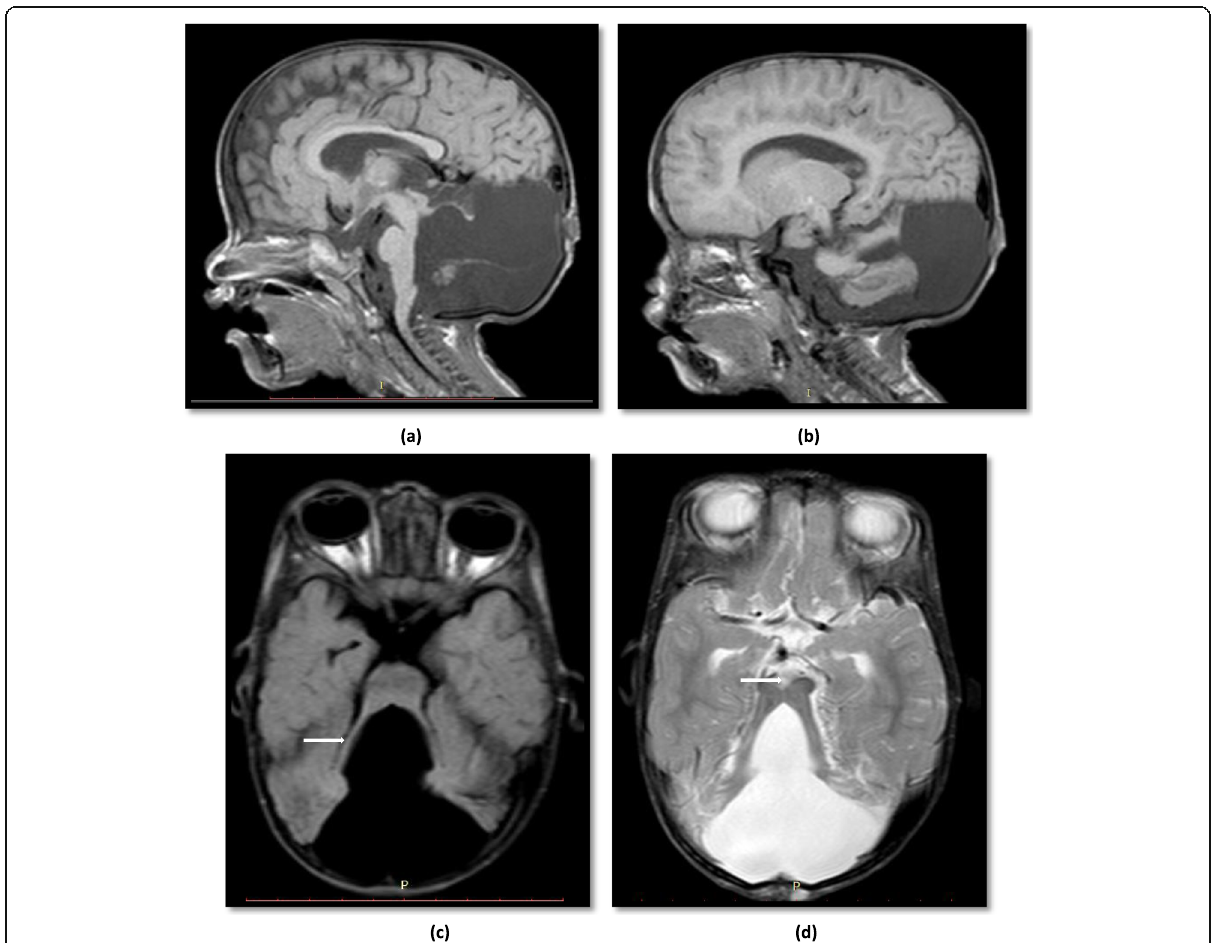
Fig. 1 MRI of a 3-year-old boy with seizures and delayed motor and mental development. a , b Sagittal and parasagittal T1-weighted images of the brain show cystic dilatation of the fourth ventricle which extends posteriorly filling out nearly the entire posterior fossa, and cerebellar hypoplasia mainly involving the vermis. Elevation of tentorium and torcula with mild hydrocephalic changes. c , d FLAIR and axial T2-weighted image shows the molar tooth sign with elongated, thickened, and horizontally orientated superior cerebellar peduncles (arrows) and a deepened interpeduncular fossa. Final diagnosis: DWM with Joubert